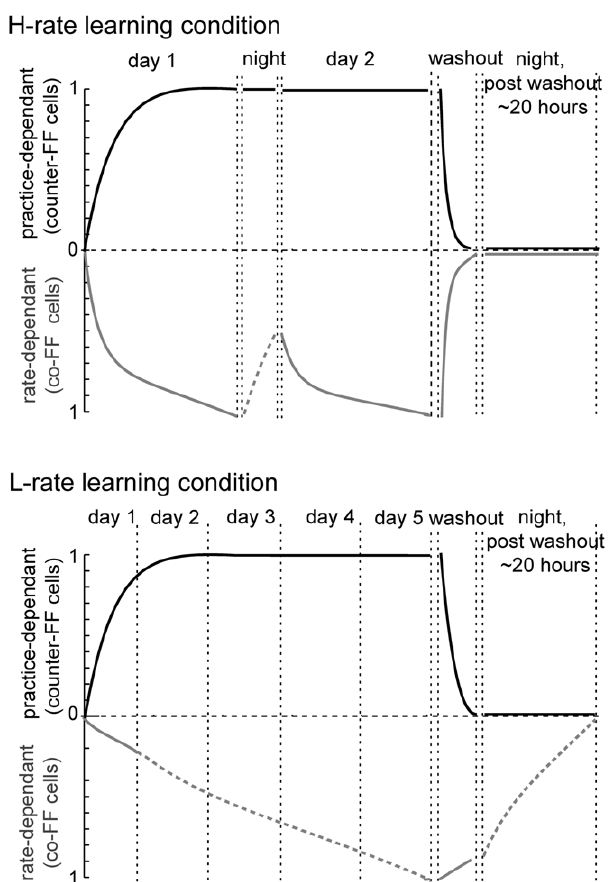
Figure 10. A qualitative scheme of the schedule-dependent and practice-dependant neuronal processes can account for the observed behavioral changes during learning. The evolve- ment of the practice-dependent process that reflects the observed dynamics of counter-FF cells (black) and the schedule-dependent process reflecting the co-FF cells (grey). The scale is set arbitrarily from zero to one to represent a transfer from a naive state to a fully adapted state. The behavior reaches plateau only when the two processes reach one. Solid lines are based on observed results and dashed lines - speculations. During H-rate (upper plots) both processes reach the value of one on the first day. An ‘‘overnight drop’’ in the value of the schedule-dependent process re-emerged on the second day, corre- sponding to the observed overnight drop in performance (as in Figure 3A) and the change of only the co-FF cells in the second day (as in Figure 6). The washout results in a reversed change (as in Figure 5B) of both processes to zero, reflecting the diminishing aftereffects (as in Figure 3C). During the L-rate (bottom plots), the practice-dependent process evolved as in the H-rate, but it took more time, since trials appeared at a lower rate. The development of the schedule-dependent process was slower. The curve is only speculative to illustrate the slow development. The washout in the L-rate reversed only the practice- dependent process (as in Figure 5B, black). We assume that the schedule-dependent process was reversed overnight since the ob- served results did not show aftereffects on the following